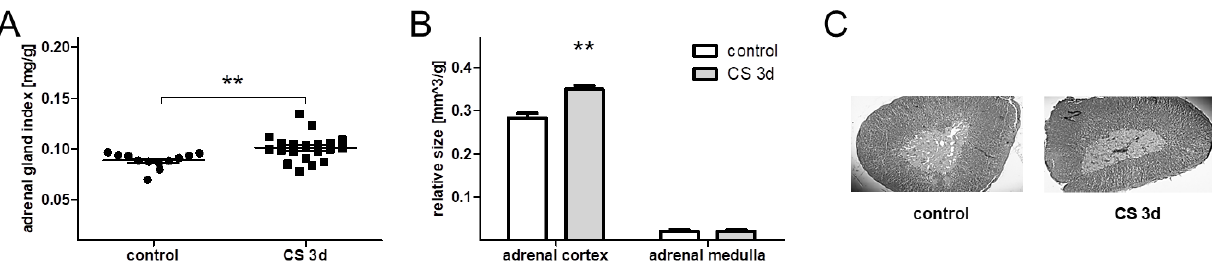
Figure 1. The concentration of adrenocorticotropic hormone (ACTH) ( A ), plasma corticosterone (CORT) ( B ), and interleukin 1 beta (IL1B) ( C ) in plasma isolated from trunk blood of rats that underwent crowding stress (CS) for 3, 7, or 14 days. Bars represent ACTH, CORT, and IL1B concentrations 1 h after the transfer of rats into separate cages and refer to the levels assessed between 1:00 am and 2:00 pm. # p < 0.05 vs. CS 3d (LSD test); ˆ p < 0.05 vs. CS 7d (LSD test). n = 16–20/group, as indicated in the graphs.